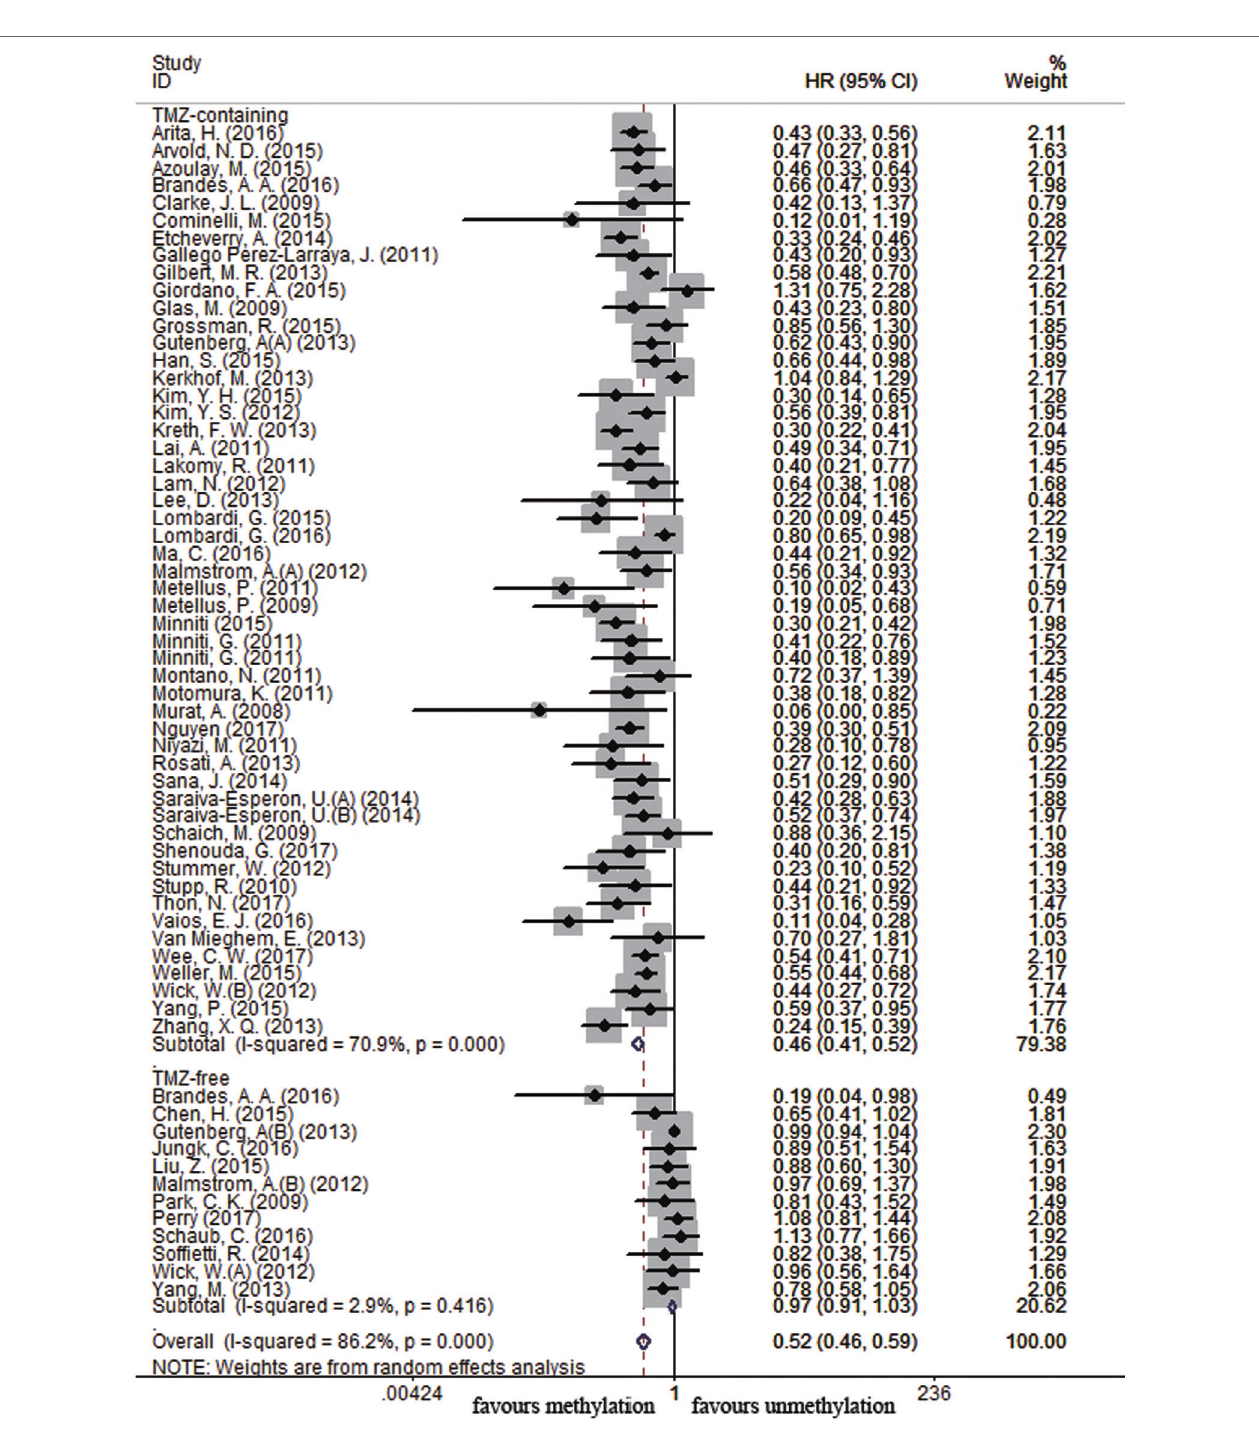
FiGURe 2 | Calculated hazard ratios (HRs) and 95% confidence intervals (CIs) for the relationship between methylation and overall survival benefit from temozolomide (TMZ)-containing or TMZ-free therapy in overall glioblastoma patients (methylated vs. unmethylated patients).